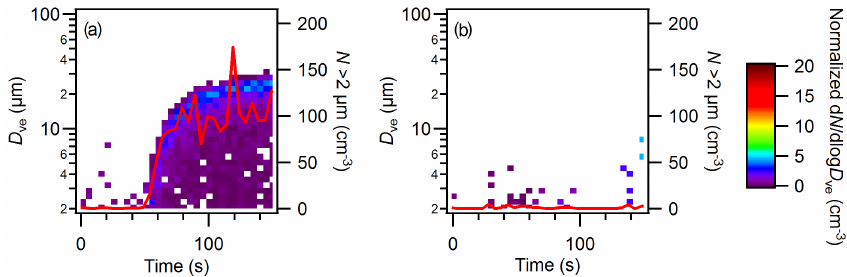
Figure 10. Temporal evolution of droplet size distributions during INUIT05_09. Normalized size distributions of droplets (d N /dlog D ve ) were derived from the measurements in the chamber (OPC 1) (a) and downstream of the IS-PCVI (OPC 3) (b) . Red lines represent the summed particle number above 2µm D ve . The enhancement factor correction was not applied due to the static mode operation of the IS-PCVI.